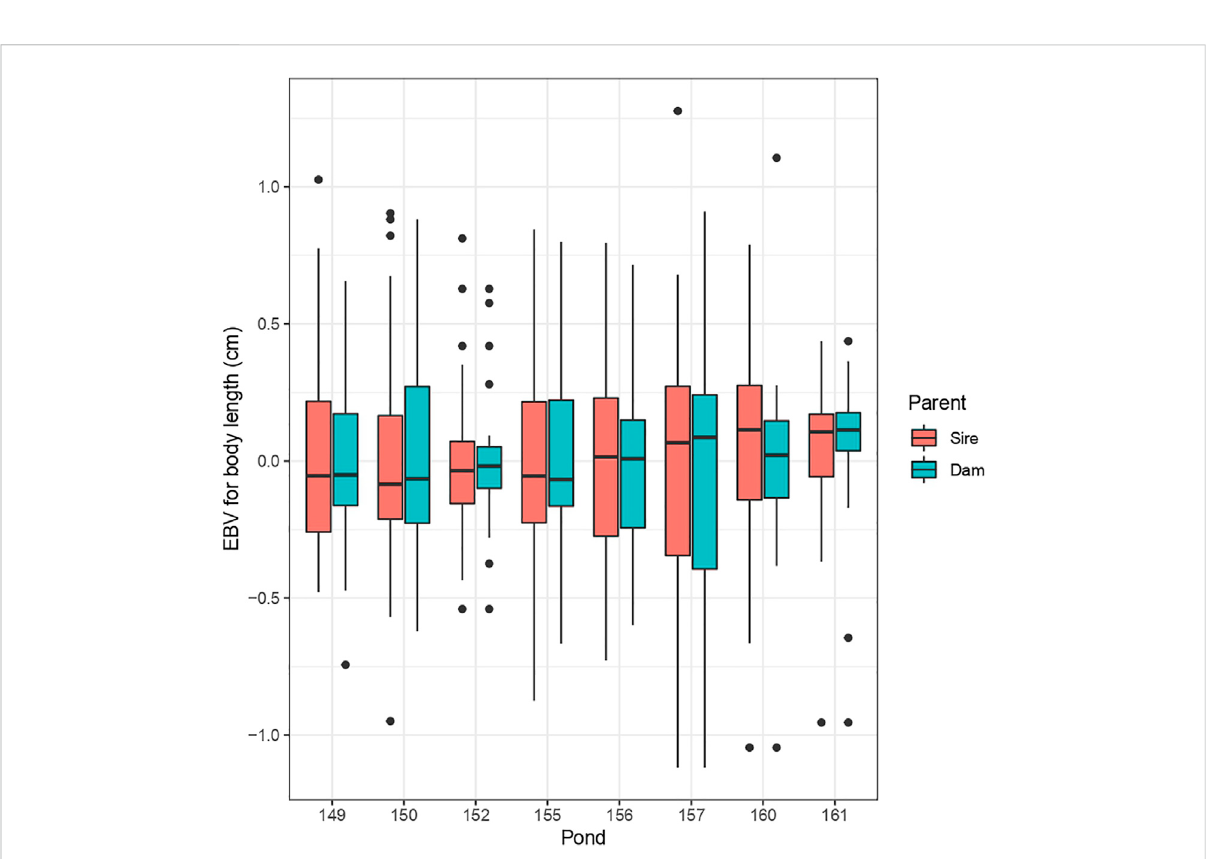
FIGURE 1 Distribution of EBVs for body length (BL) across ponds for sires and